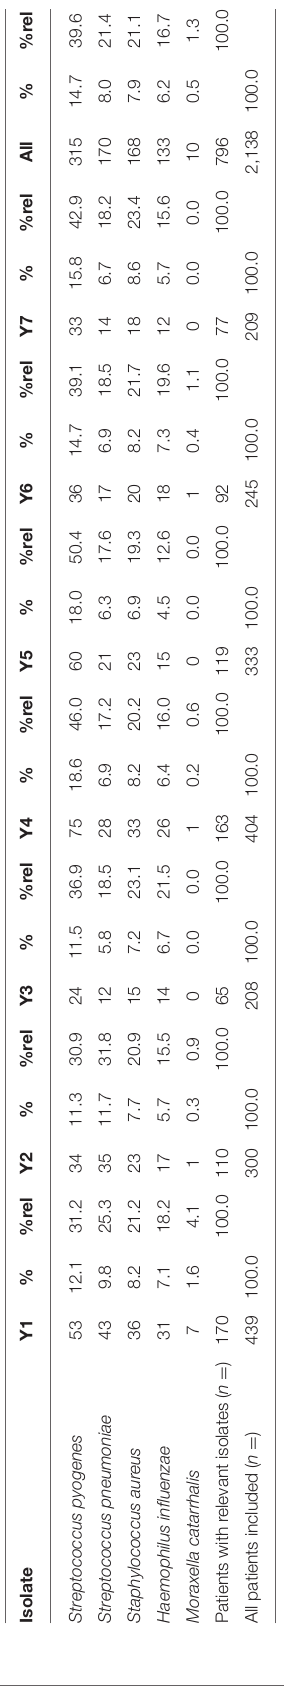
( Table 2 ). For 37 patients, two relevant strains were isolated ( S. pyogenes / S. aureus : n = 10; S. pneumoniae / H. influenzae